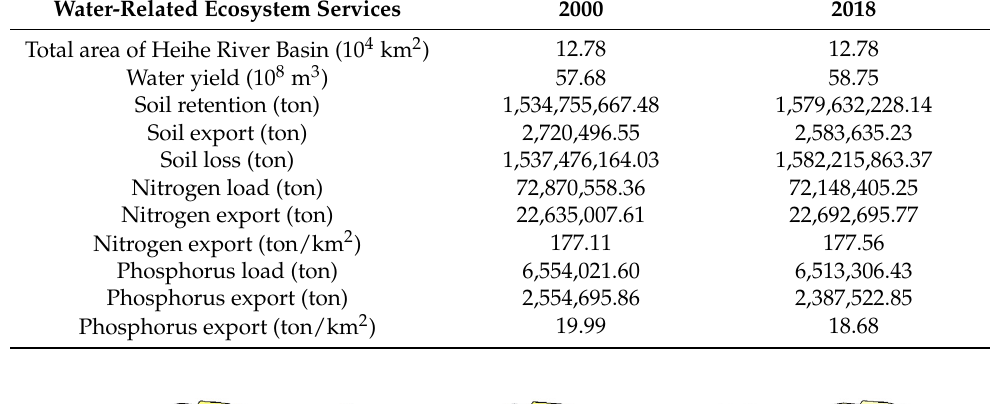
Table 3. Total amount of water-related ecosystem services in the Heihe River Basin in 2000 and 2018.